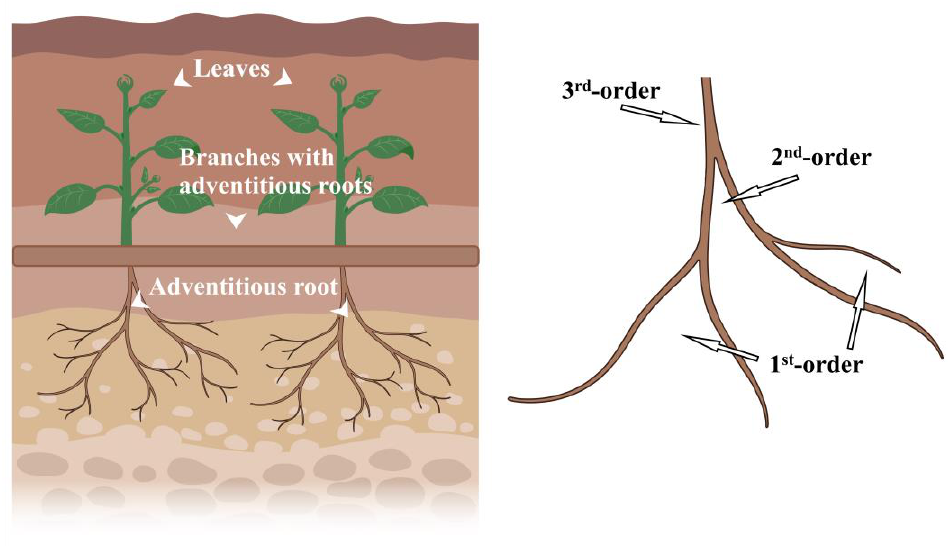
Figure 7. Grading method of adventitious roots.